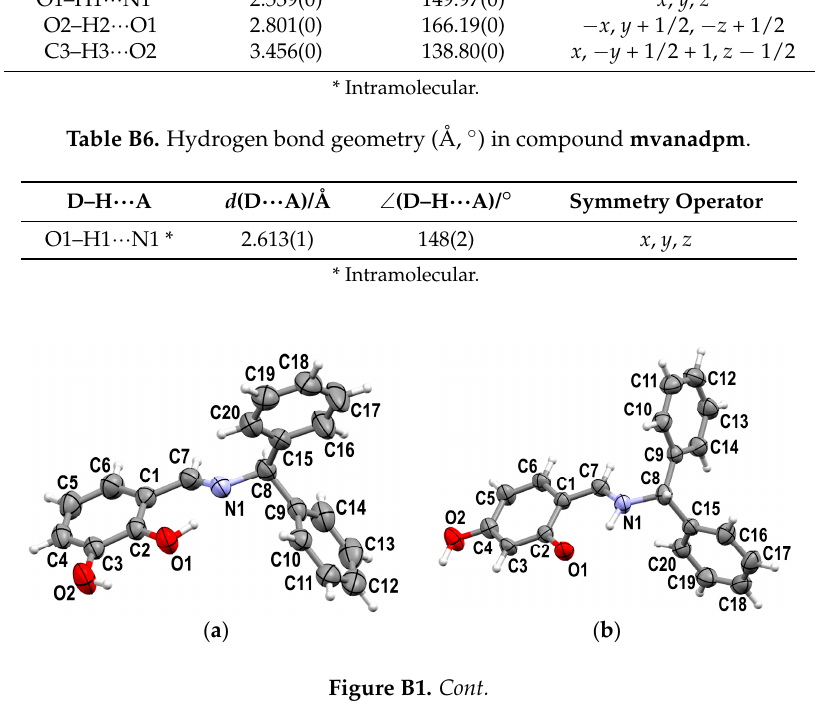
Table B5. Hydrogen bond geometry (Å, °) in compound pOHsaladpm .